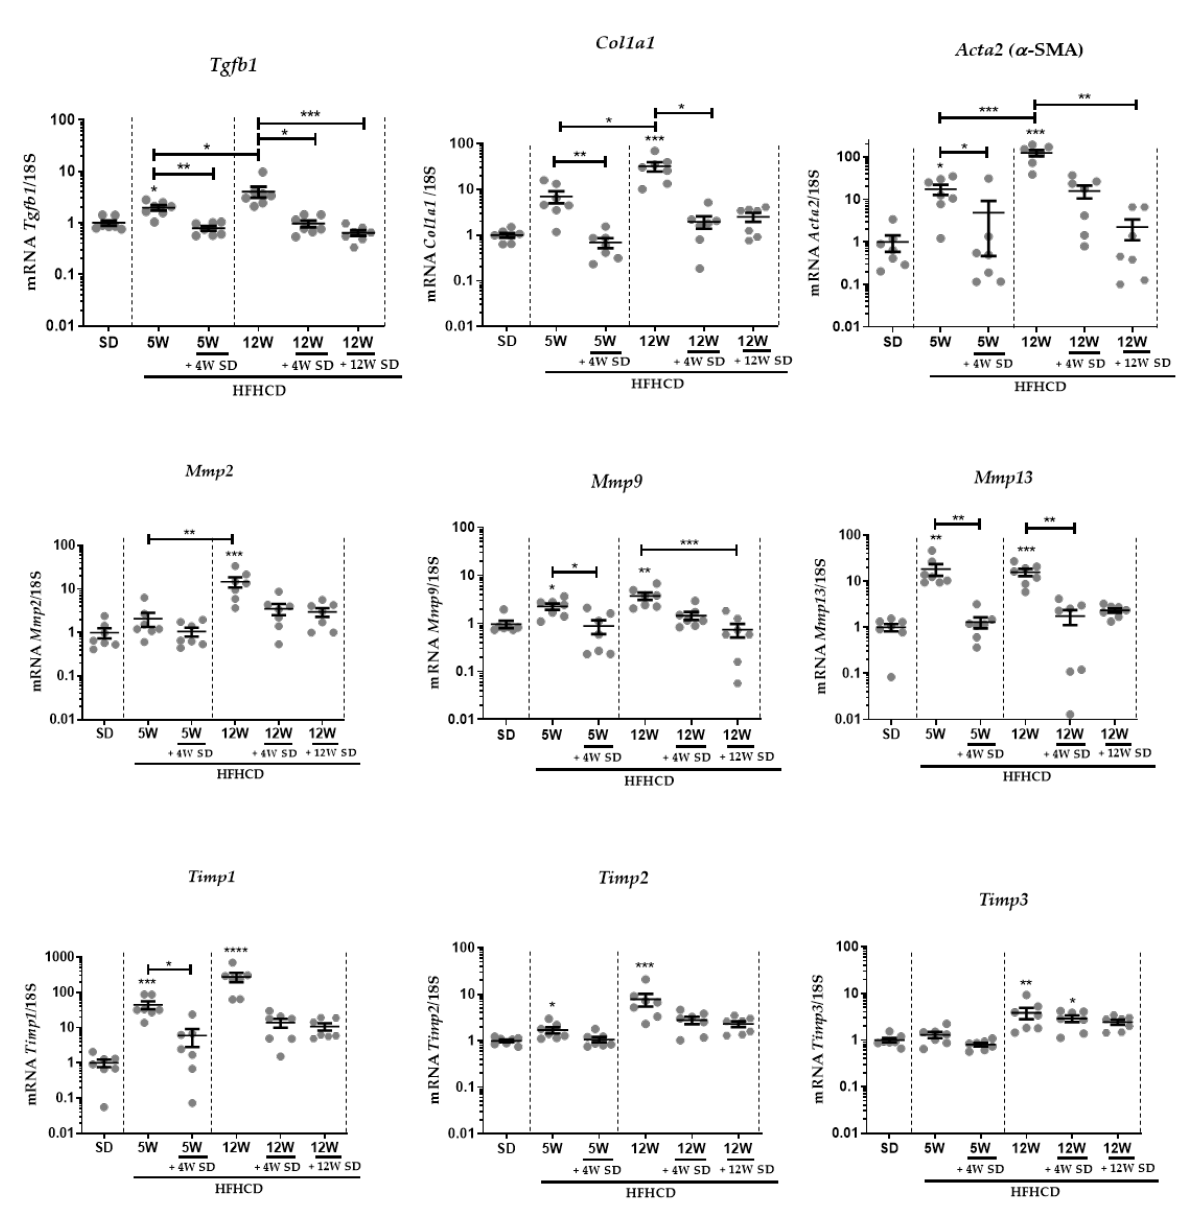
Figure 4. Liver transcript expression of genes involved in ECM deposition and degradation. Six groups of seven male mice were given separate diet regimens of either a standard diet (SD) or a high-fat, high-cholesterol diet (HFHCD) for 5 or 12 weeks (W), with some groups returning to the SD on an additional period of 4 or 12 weeks. Liver transcript expression of TGFB1, Col1a1, Acta2 (αSMA), Mmp2, Mmp9, Mmp13, Timp1, Timp2 and Timp3. For all graphs, each dot represents an individual, and error bars are expressed as means ± SEM (* p < 0.05, ** p < 0.01, *** p < 0.001 and **** p < 0.0001).